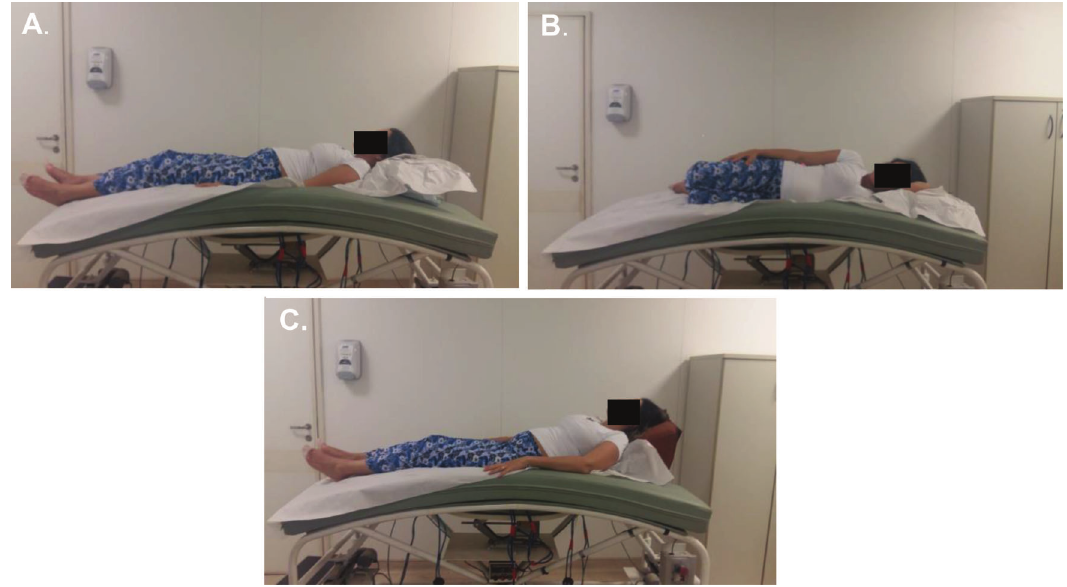
Figure 2 - A. Supine position with a 15-degree tilt B. Left lateral position with support for the lower limbs C . Fowler ’ s position, i.e., semi-upright with slightly flexed knees and a 45 o support placed behind the